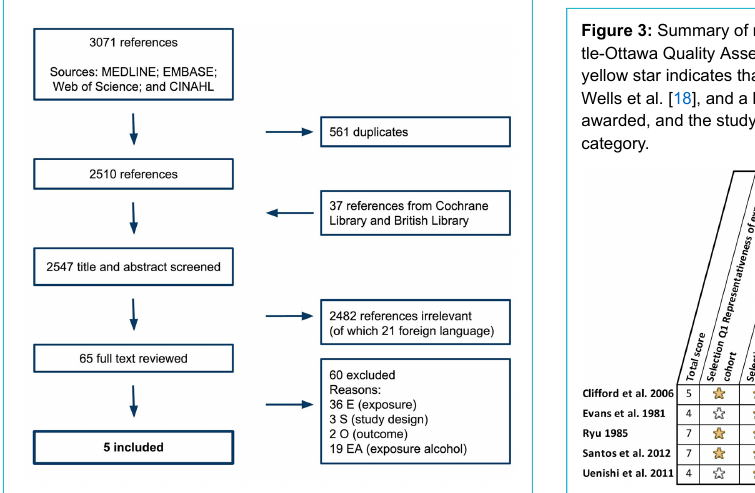
Figure 2: PRISMA flow chart for literature retrieval and study se- lection.